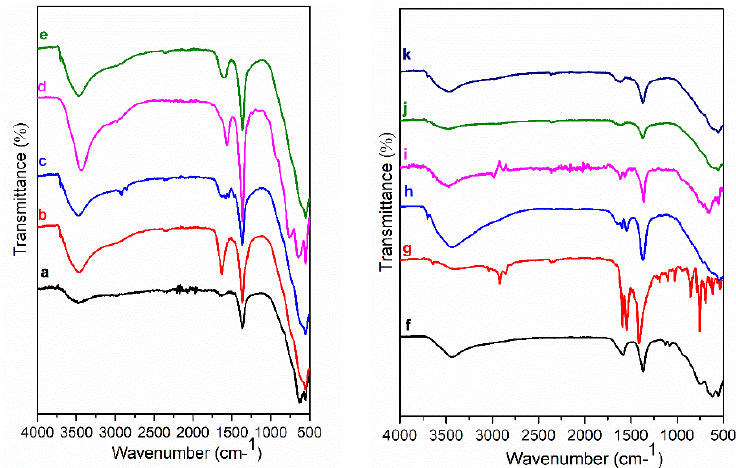
Figure 6. FT-IR spectra of Mg 3 /Al-CO 3 ( a ) and hybrid inorganic-organic LDHs: Mg 3 /Al-oxalate ( b ), Mg 3 /Al-laurate ( c ), Mg 3 /Al-succinate ( d ), Mg 3 /Al-malonate ( e ). FT-IR spectra of Mg 3 /Al-tartrate ( f ), Mg 3 /Al-4-biphenylacetonate ( g ), Mg 3 /Al-benzoate ( h ), Mg 3 /Al-1,3,5-benzentricarboxylate ( i ), Mg 3 /Al-4-methylbenzoate ( j ) and Mg 3 /Al-4-dimethylaminobenzoate ( k ).